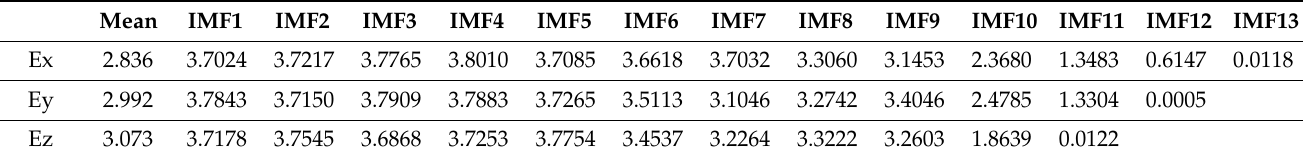
Table 1. Sample entropy and its mean value of each IMF of 109,751.